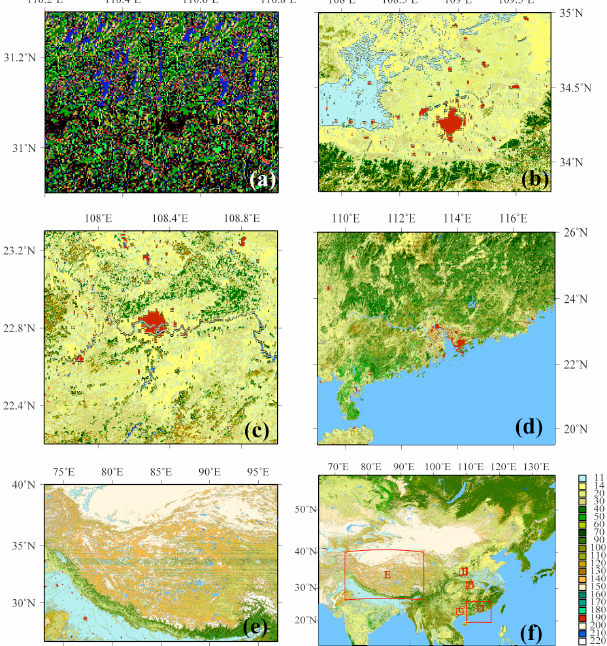
Table 2. Statistics of DEM inter-comparisons with CSI SRTM Figure 4. Land cover map with geographical distribution of the 22 classes over the five test areas (a, b, c, d, e) and China (f) plotted on GlobCover v2.2 product (copyright by ESA GlobCover Project). The GlobCover global legend on the right of Figure 4(e) contains 22 classes extracted from Table 2 reported by Bicheron et al .